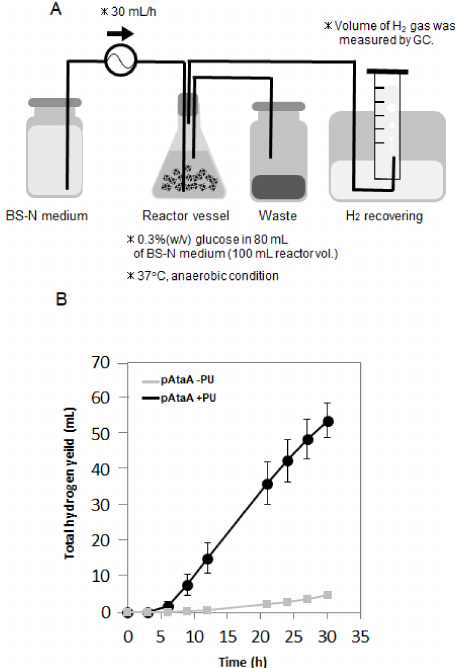
Figure 5. Continuous hydrogen production by immobilized E. aerogenes in a flow reactor. The flow reactor was inoculated with immobilized or planktonic cells. ( A ) Measurement procedure of hydrogen yields during the reactions. ( B ) Hydrogen yield versus time in the flow reactor with immobilized-cells on polyurethane (pAtaA +PU: black) and with the planktonic-cell (pAtaA -U: gray). Data are the mean ± SD of three independent